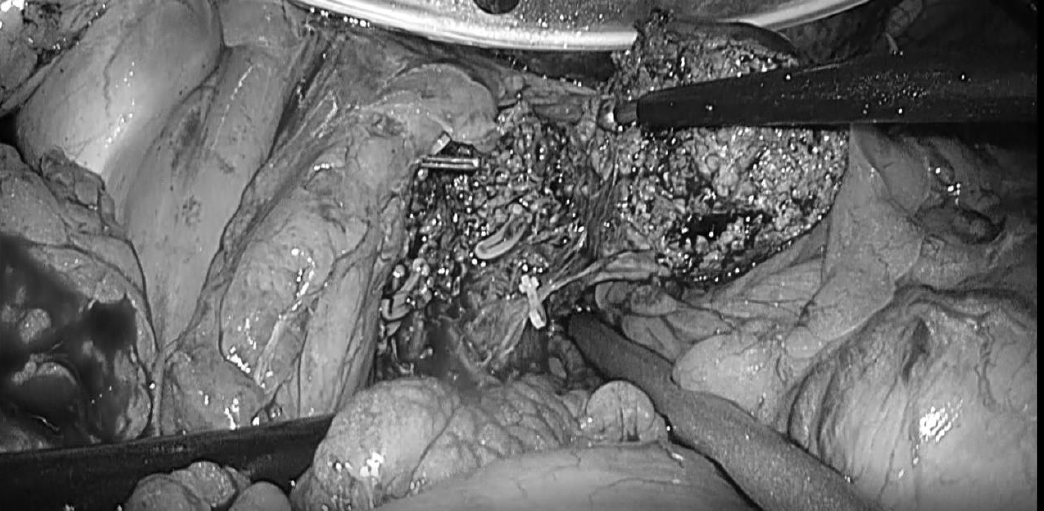
Figure 3. Laparoscopic liver resection for tumor located at segment I in a patient with obesity. Taking advantage of the Caudal approach of laparoscopic surgery, liver resection was performed with a good field of view despite the surgical depth.